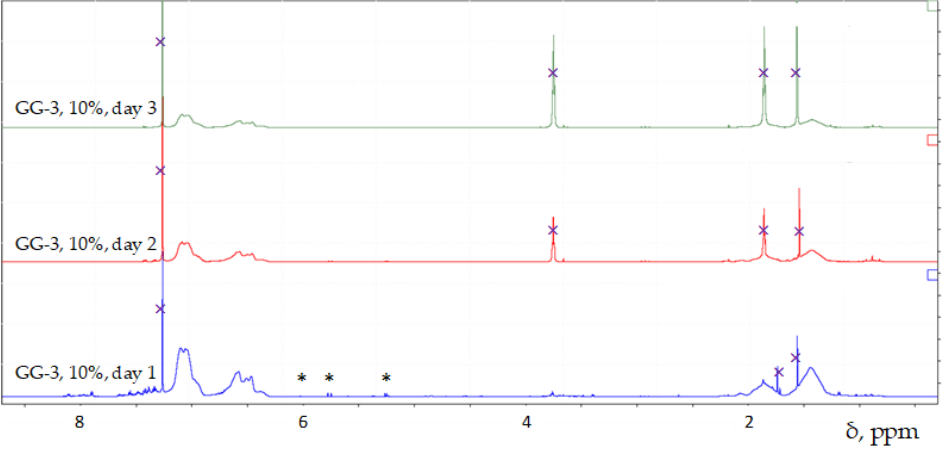
Figure 7. 1 H NMR spectra of products extracted with CHCl 3 PSt-VBzGG-3 1 wt% SIPN over 24, 48, and 72 h. (GG-3) — PSt-VBzGG-3 1 wt% SIPN. (*) — unreacted styrene, (×) — solvent signals.